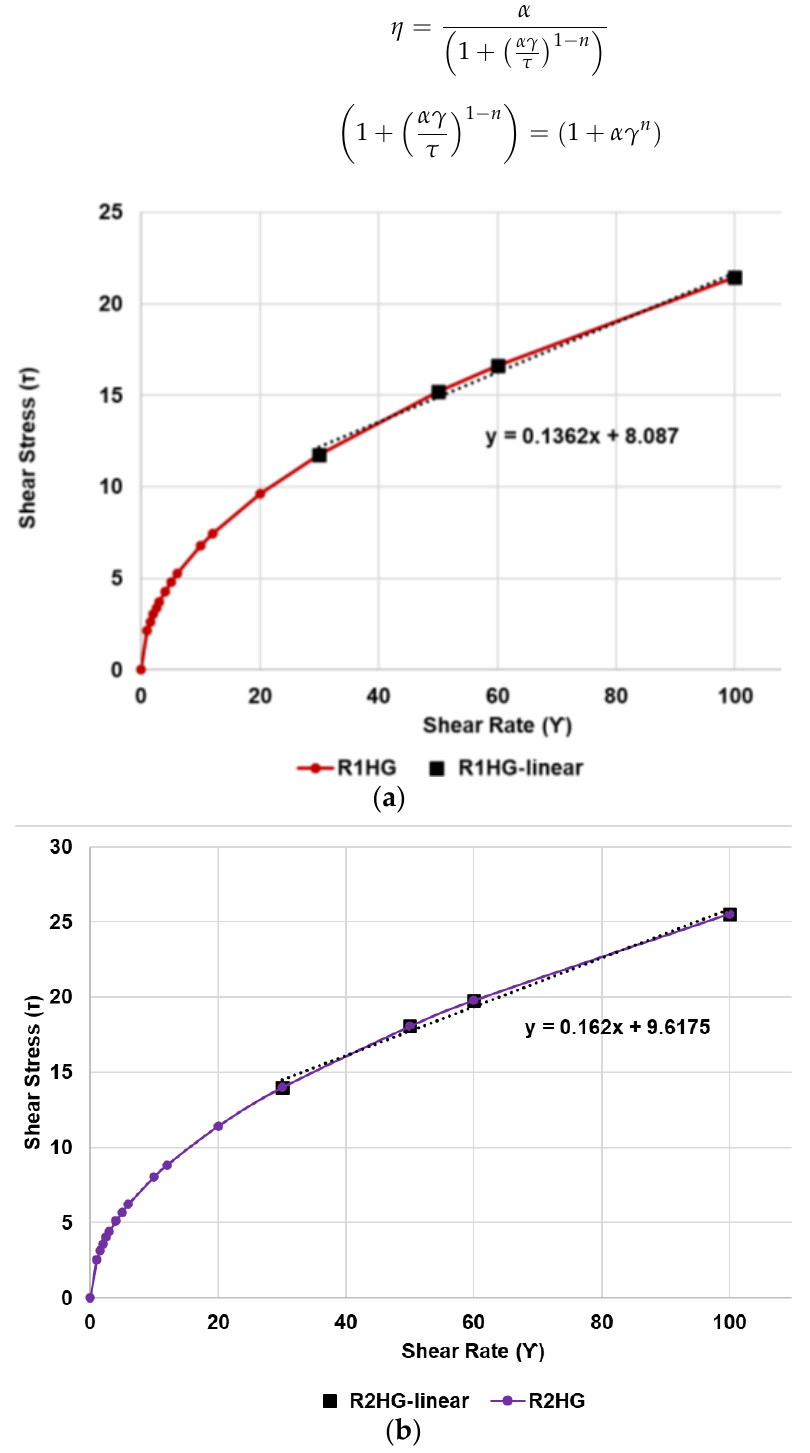
Figure 11. Plots of shear stress ( τ , Pa) vs. shear rate ( γ , s − 1 ) of R1HG ( a ) and R2HG ( b ). The intercepts of equations associated to the linear tracts of both the curves provide the values of yield stress.